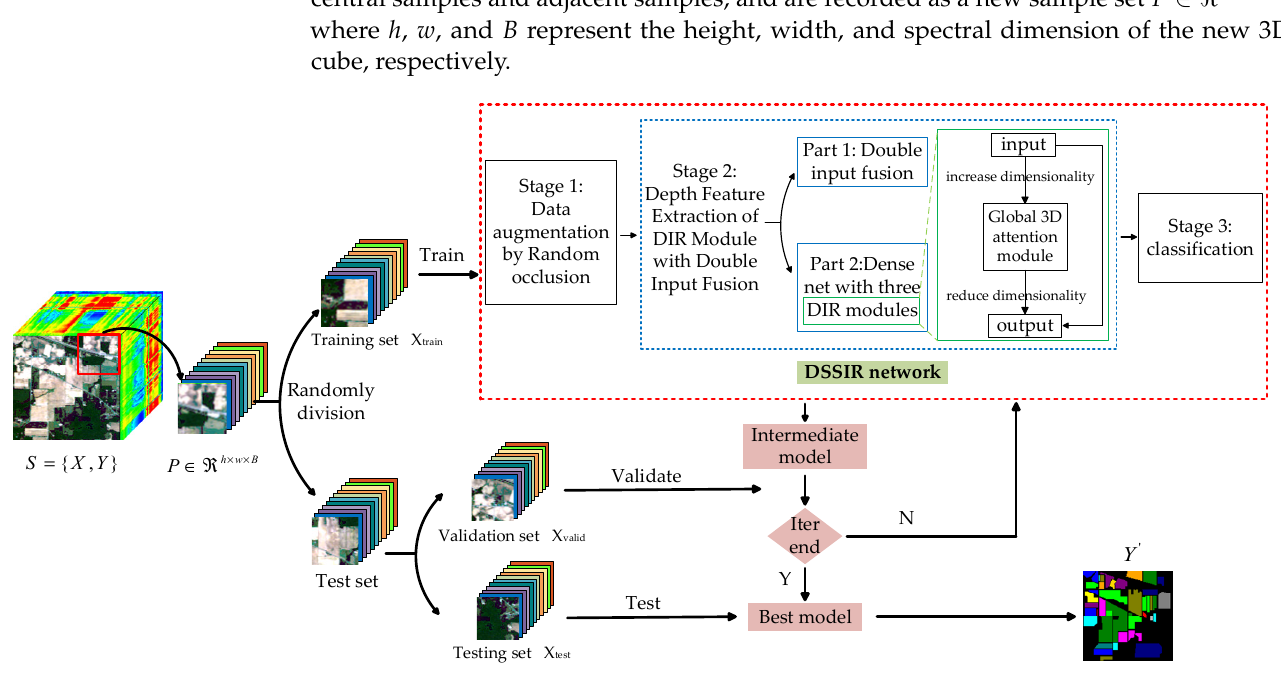
Figure 1. The overall framework of the proposed